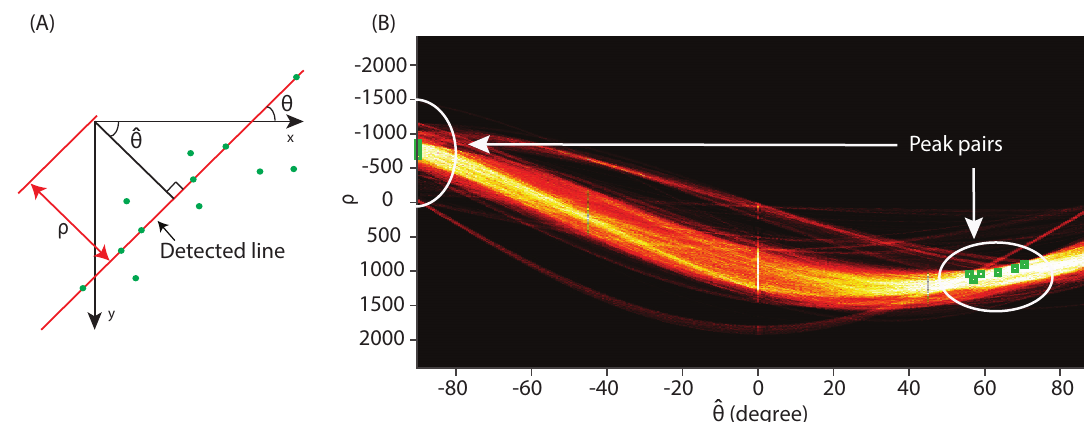
Figure 3. Illustrative demonstration of Hough transform: ( A ) line detection process. The green points are the bright pixels on the skeletonized actin cytoskeleton images. The red line is detected based on the green points. ˆ θ is the angle of the perpendicular projection from the origin to the detected line measured in degrees anticlockwise from the positive x -axis. ρ is the distance between the origin and the detected line. The (ˆ θ , ρ ) pair is given by Hough transform. θ calculated through ˆ θ is the angle of the detected line. ( B ) Hough space graph of the Canny skeletonized image in Figure 2C. The green points are the (ˆ θ , ρ ) pairs at which at least 10 curves